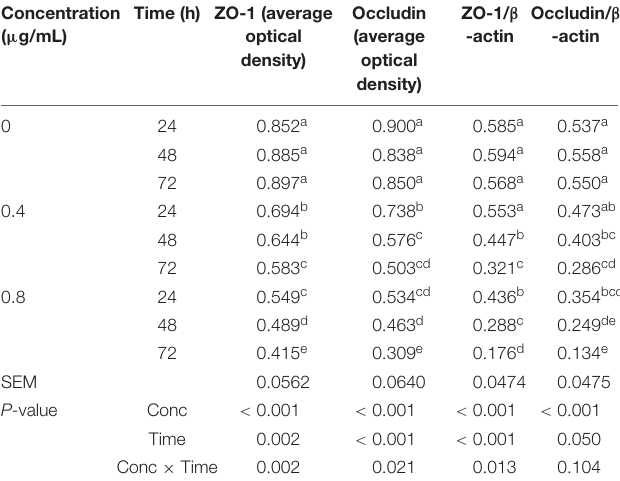
TABLE 5 | Effects of α -chaconine on the permeability and structural integrity of mouse intestinal epithelial cells. Concentration ( µ g/mL)